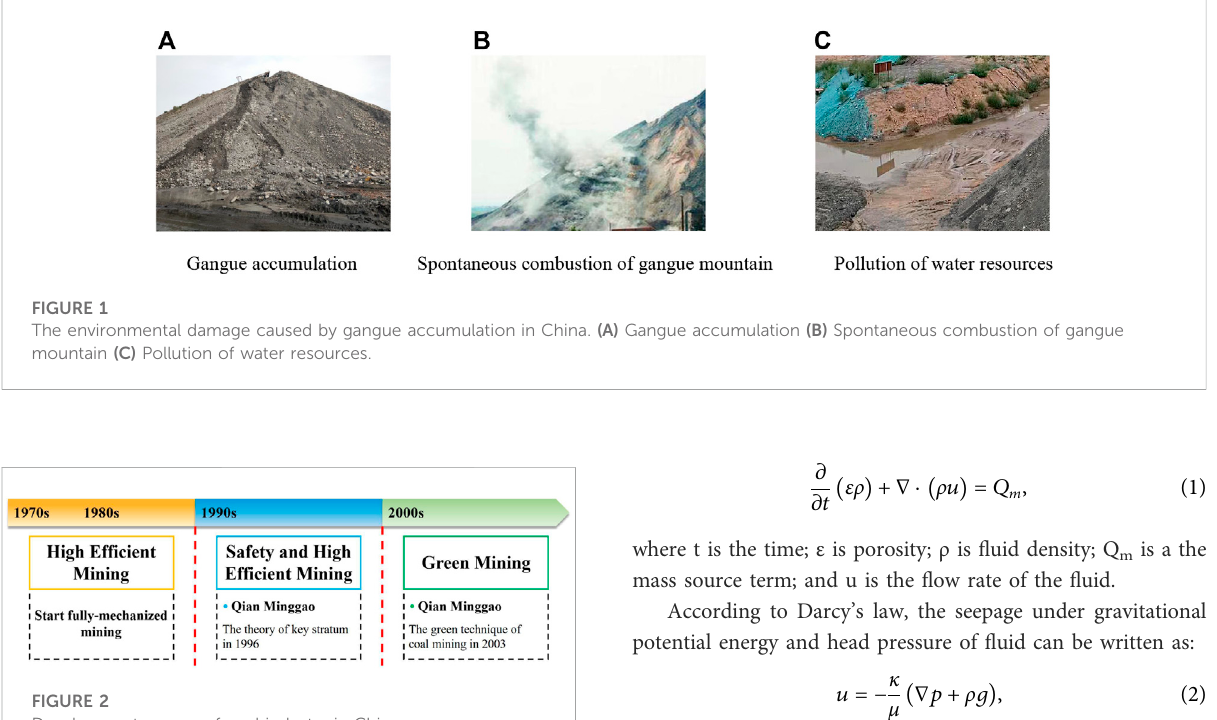
FIGURE 2 Development course of coal industry in